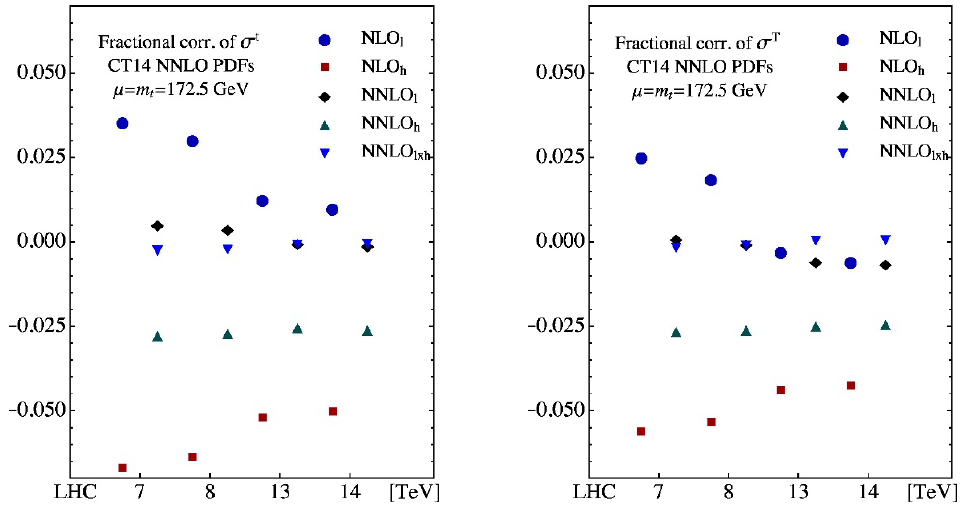
Figure 18 . Fractional corrections for the inclusive cross sections of t -channel single top quark and anti-quark production at NLO and NNLO at the LHC with di(cid:11)erent center of mass energies, computed with CT14 NNLO PDFs, and separated into component